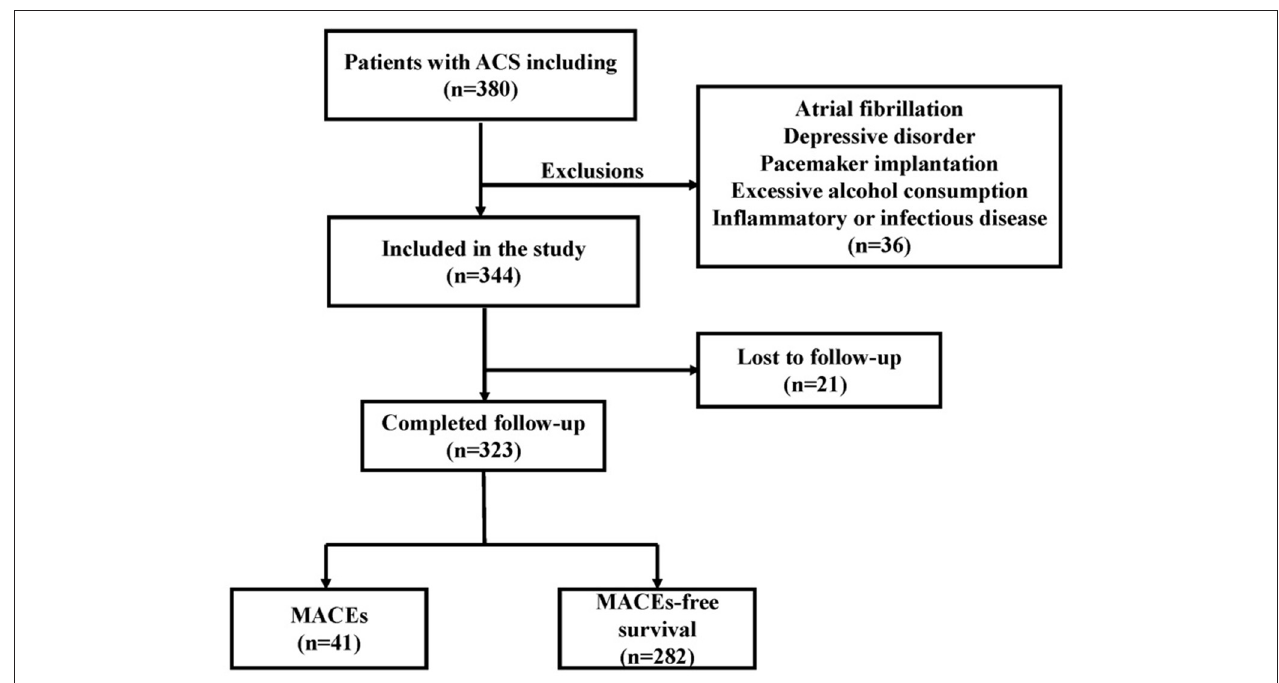
FIGURE 1 | Flowchart of patient